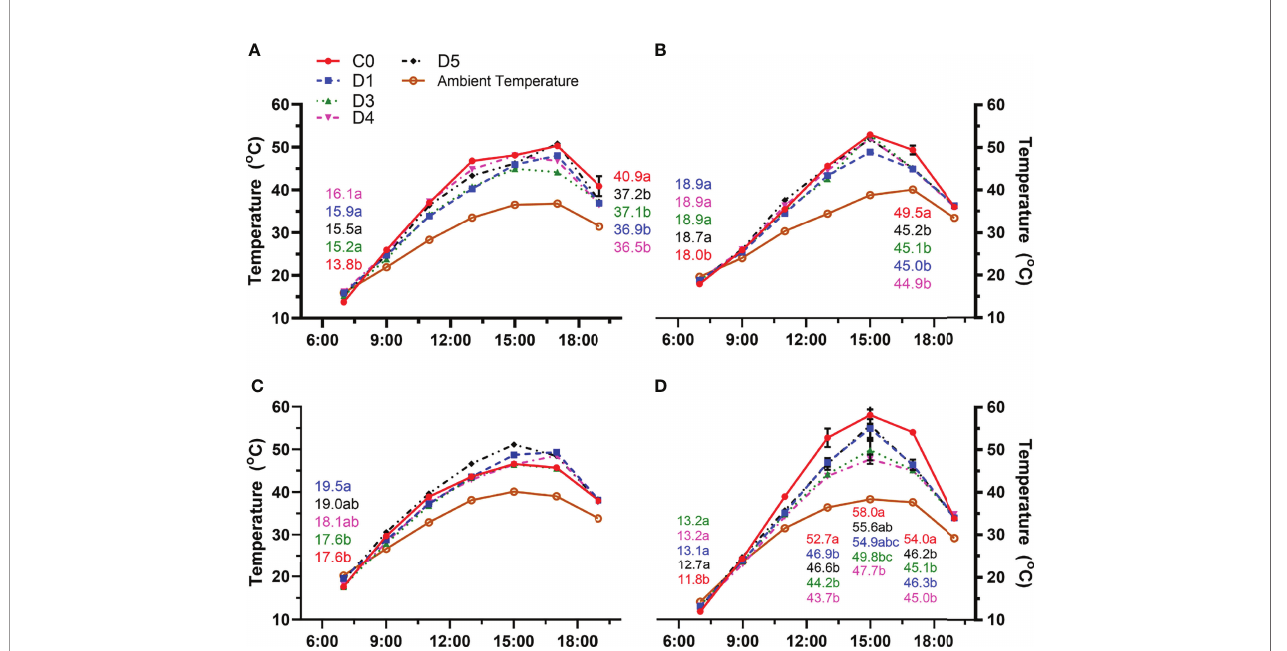
FIGURE 3 | Air temperature and cluster temperature of control (C0) and vines under shade fi lms (D1, D3, D4, D5) recorded during heat wave events both pre-verasion and post-verasion. Temperatures were recorded pre-verasion on (A) 11 July 2020 and (C) 17 June 2021 and post-verasion on (B) 18 August 2020 and (D) 28 August 2021. Points are means ± standard error ( n = and C0 having the highest titratable acidities. D4 and D5 had ( Figure 5C ). When compared together, the shade fi lms had similar TA, which was signi fi cantly less than D1 ( Figure 5D ). similar pH at the green berry stage. There were no further Titratable acidity did not differ between shaded and control differences in pH between treatments and control as ripening fruit at harvest. progressed. The TA only differed at mid-ripening with D1, D3